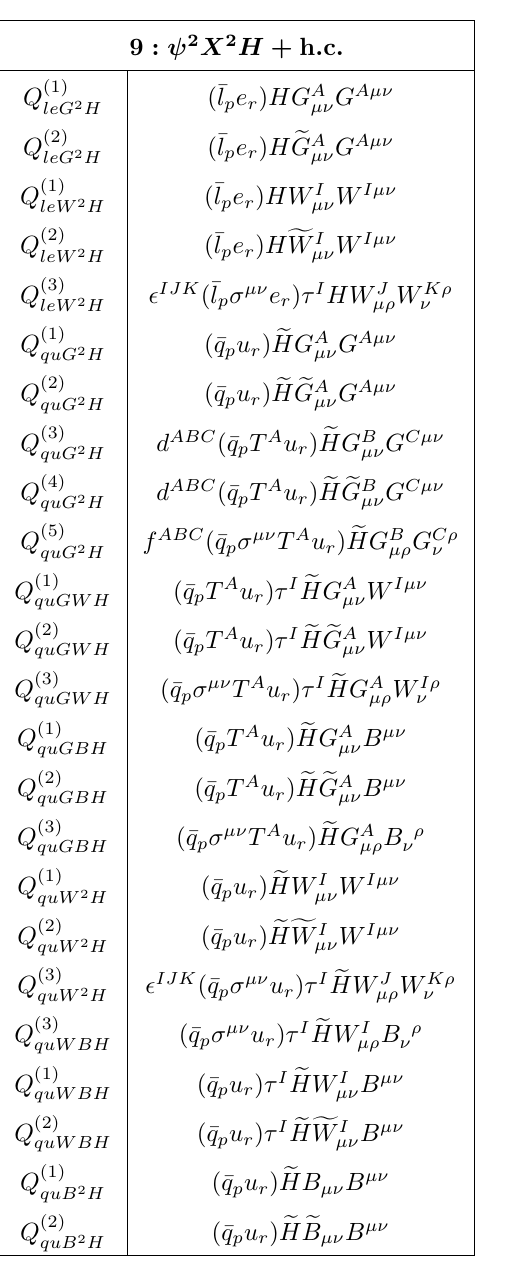
Table 4 . The dimension-eight operators in the SMEFT of class-9 with (cid:12)eld content 2 X 2 H . All of the operators have Hermitian conjugates. The subscripts p; r are weak-eigenstate indices.